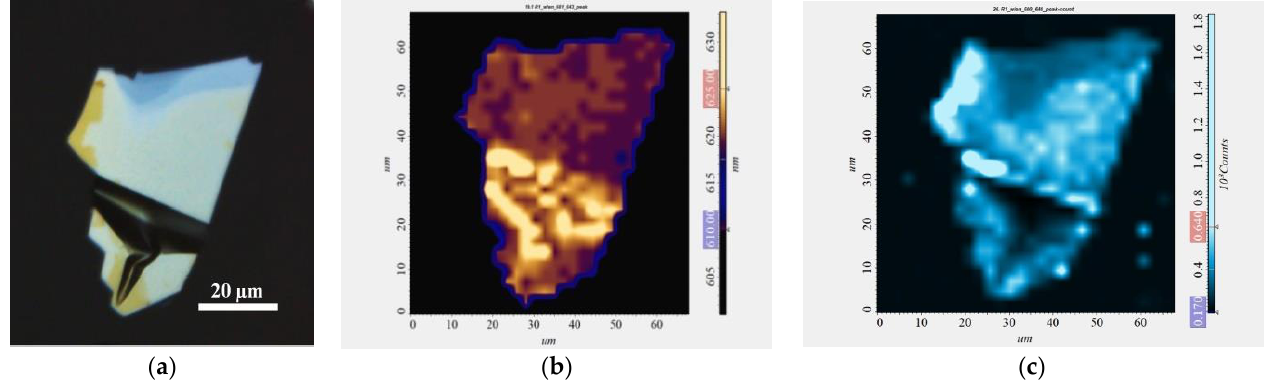
Figure 11. PL mapping of the GaSe flake ( a ) optical image; ( b ) map of PL peak position; ( c ) map of PL peak intensity.